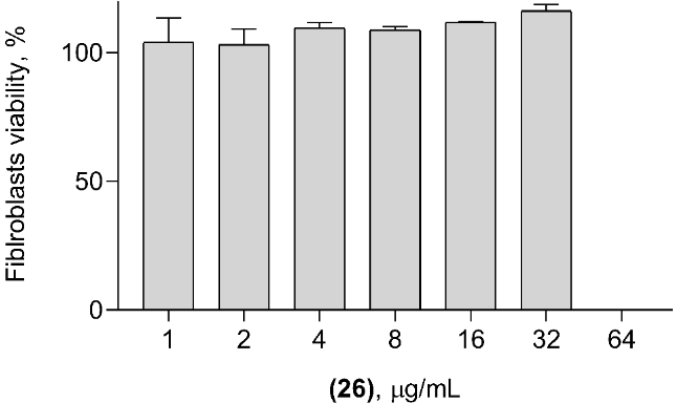
Figure 5. Cytotoxicity of 26 on human fibroblasts. The viability of non-treated cells has been considered as 100%; the mean ± SD from five calculations is shown.